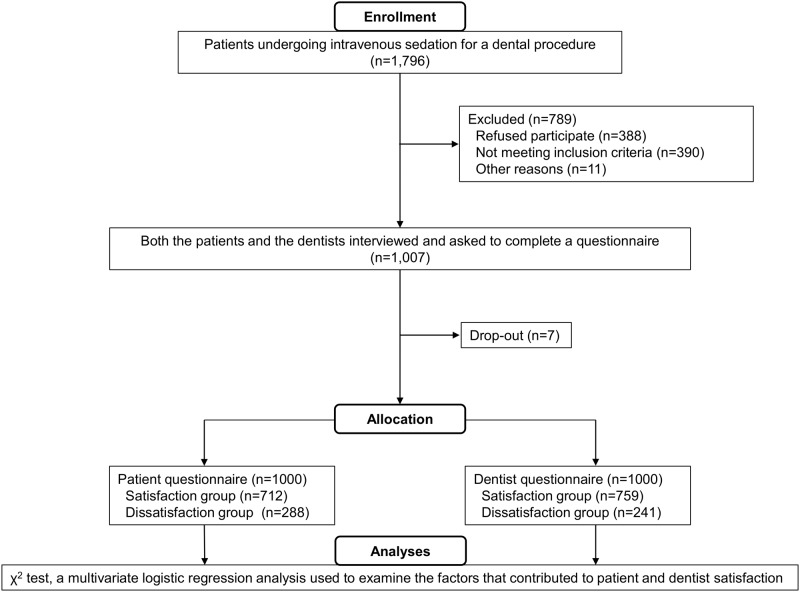
Flow chart showing enrollment, study inclusion, and data analysis.